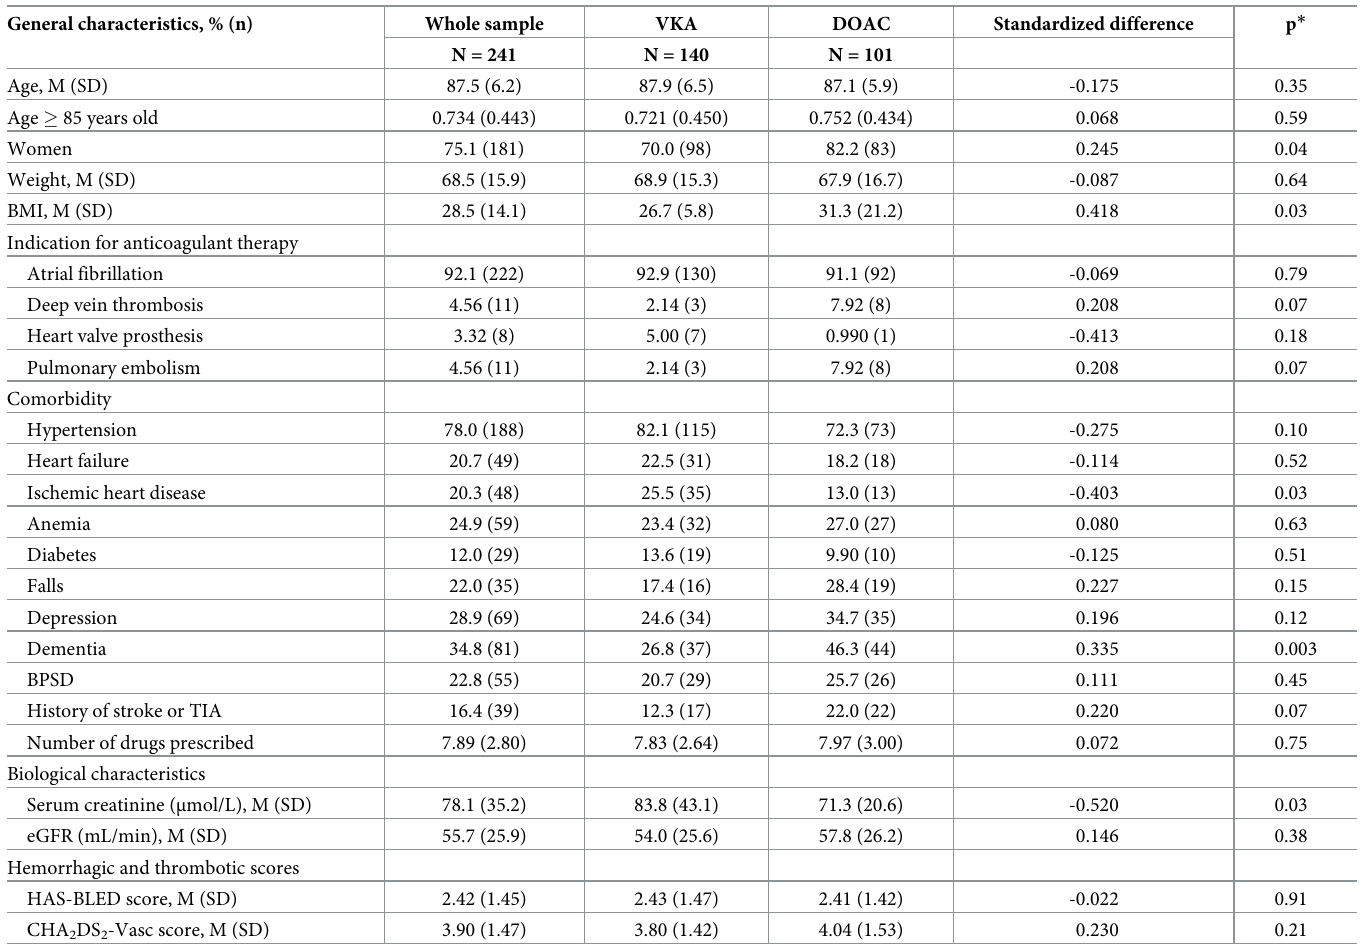
Table 2. Patients’ characteristics in the whole sample and according to anticoagulation